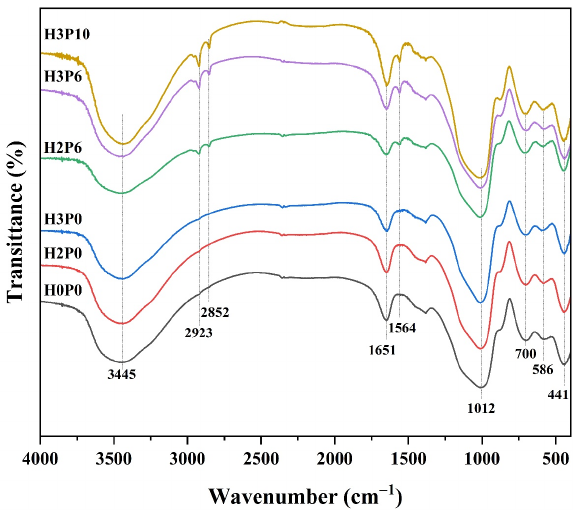
Figure 4. IR spectra of geopolymer foams with different H 2 O 2 and palm olein content. For all samples, the absorption band around 1012 cm − 1 corresponds to the symmetrical vibration of Si (Al)-O-Si bonds is observed, while the absorption peak corresponding to the in-plain bending vibration of Si-O bond appears at 441 cm − 1 [39]. The absorption bands located at 700 and 586 cm − 1 are related to the bending vibration of Si-O-Si and Si-O-Al bonds. This illustrates the formation of aluminosilicate structures in the matrix and geopolymer foams. Typical absorption bands corresponding to the stretching and bending vibration of H-O-H and O-H groups from free water and bound water are observed around 3445 and 1651 cm − 1 [40], respectively. Three new absorption peaks around 2923, 2852, and 1564 cm − 1 appear in the IR spectra of geopolymer foams with palm olein addition, corresponding to the stretching vibration of -CH 2 - and -COO − [41]. This reveals the existence of long-chain fatty acid salts in geopolymer